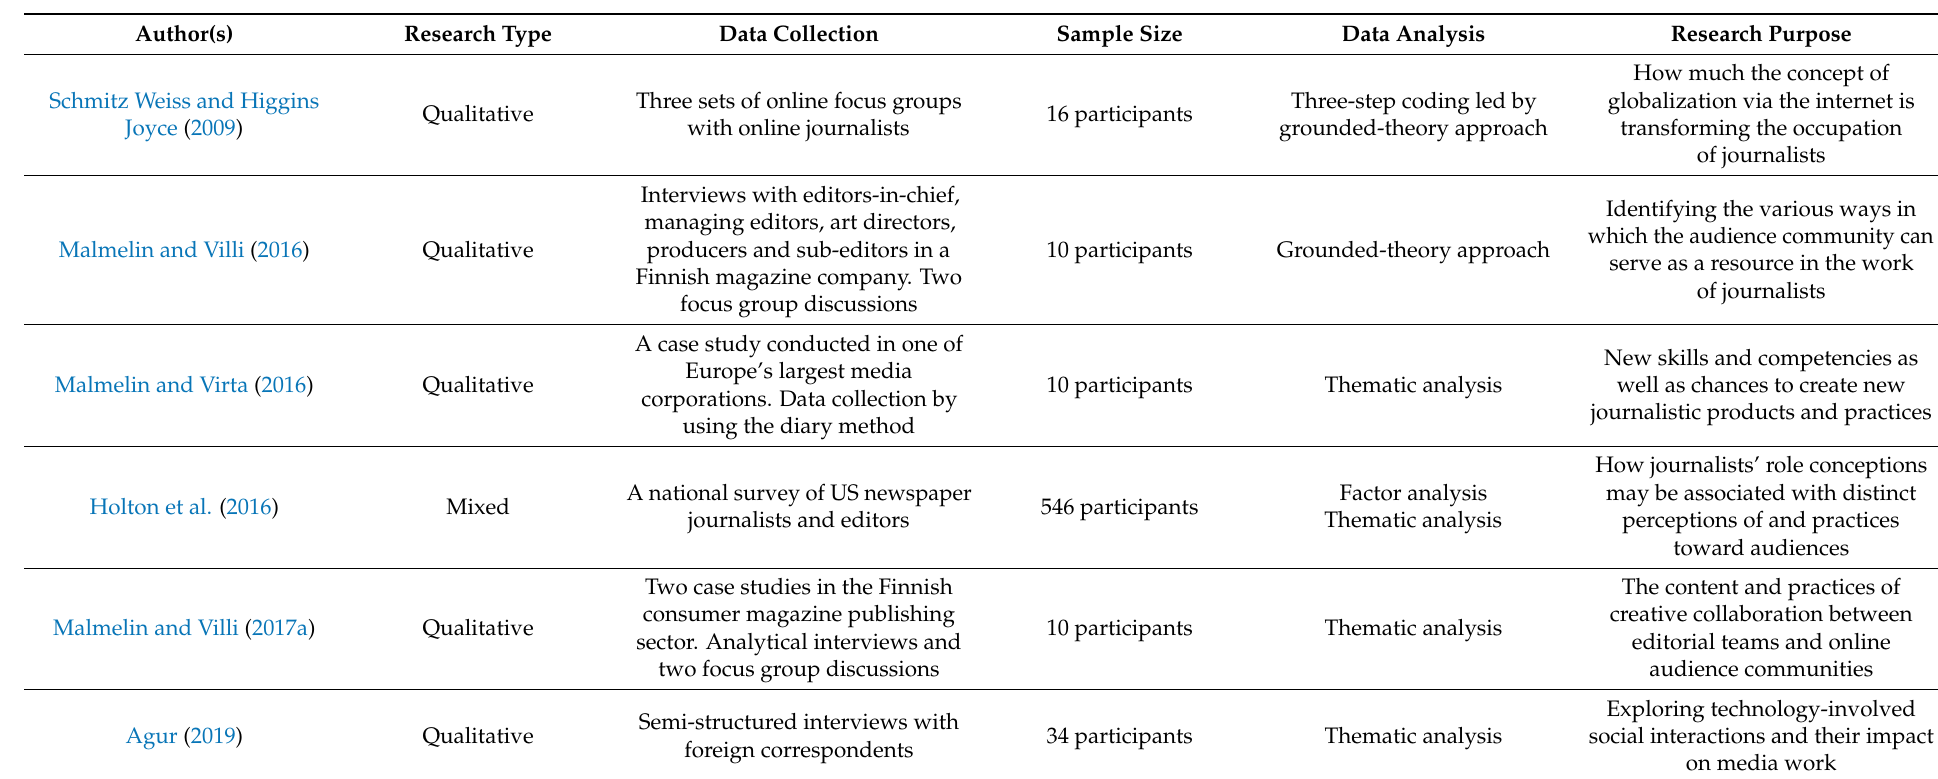
Table 7. Distribution of papers in the subtheme “emerging